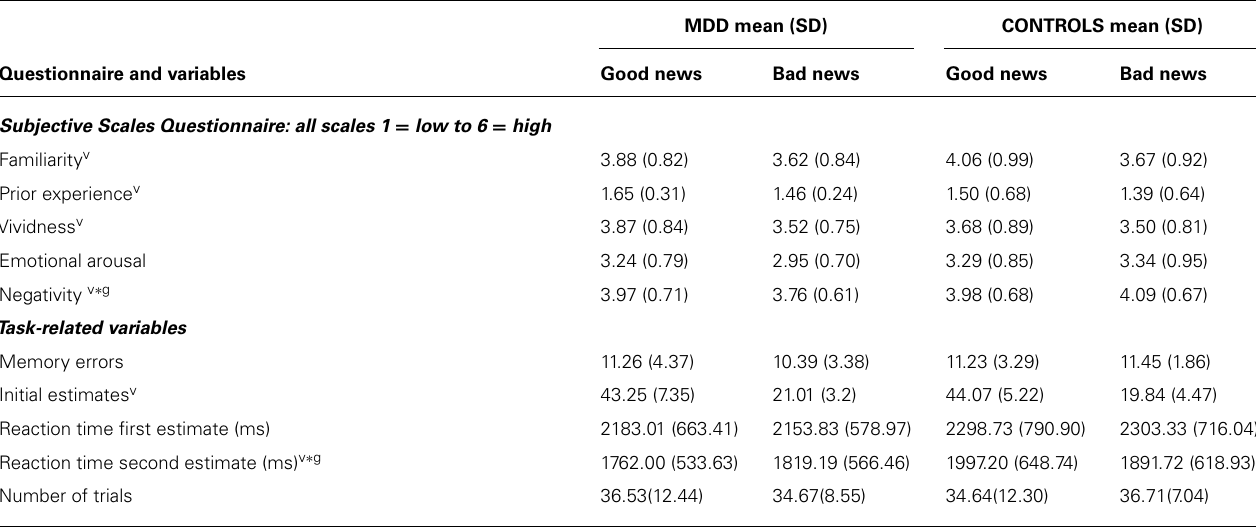
Table 2 | Participants’ ratings of familiarity with stimuli, prior experience, vividness, arousal, negativity, memory, initial estimates, reaction times and number of